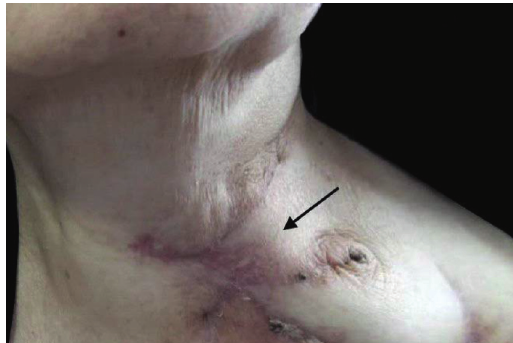
Figure 4: External view of the neck. Flash showing the supra- clavicular flap pedicle, demonstrating a viable flap after 2 months of surgery.